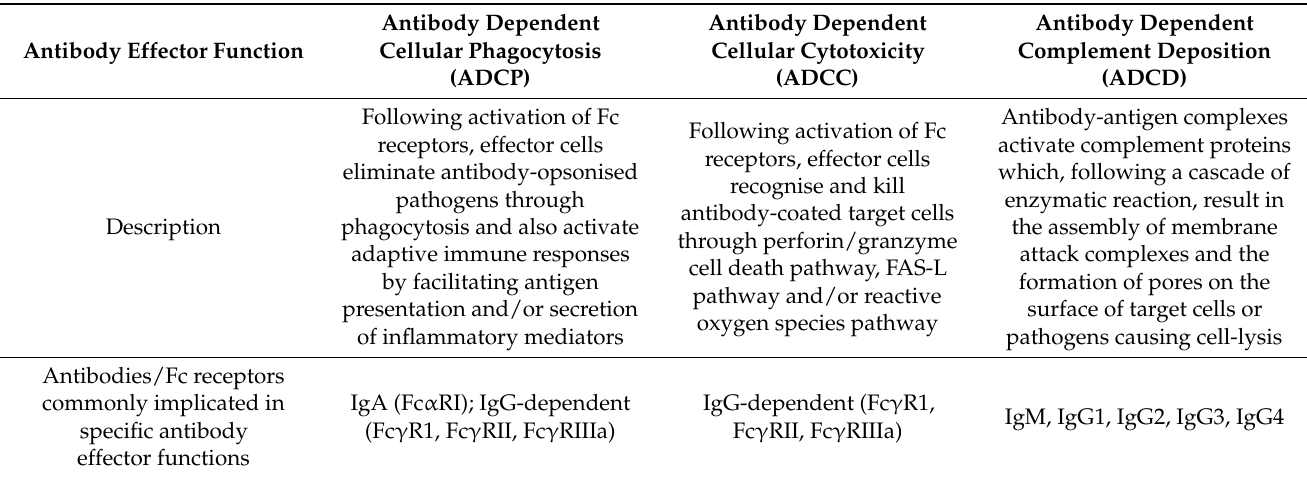
Table 1. Summary of antibody effector functions